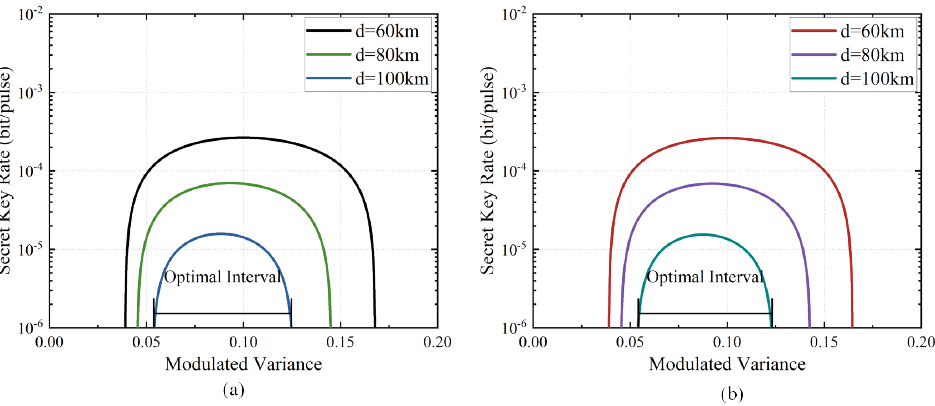
Figure 2. The secret key rate as a function of the modulated variance V M for the given transmission distance d ∈ { 60,80,100 } km of ( a ) eight-state DM DVQKD and ( b ) four-state DM CVQKD.